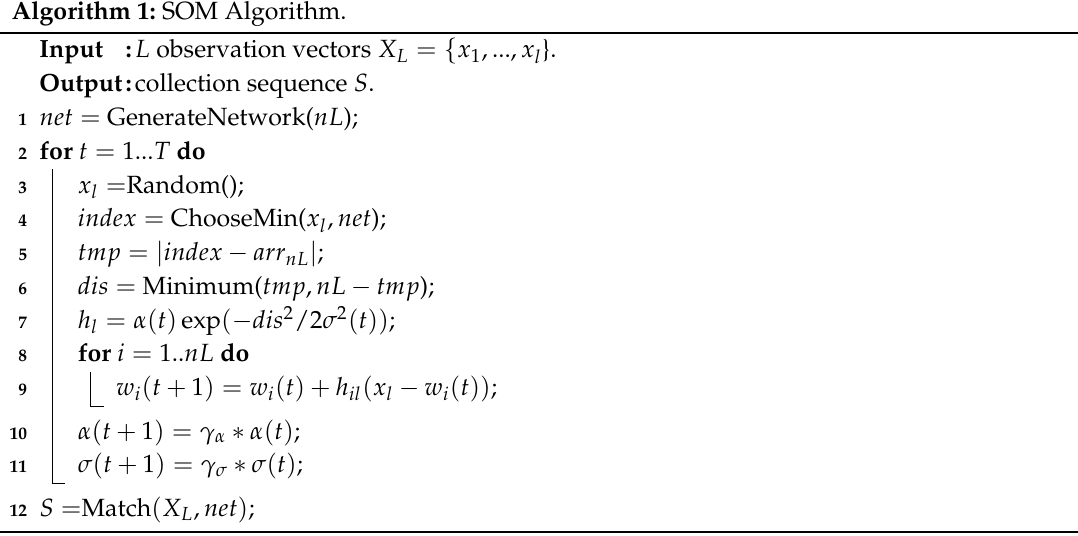
Algorithm 1: SOM